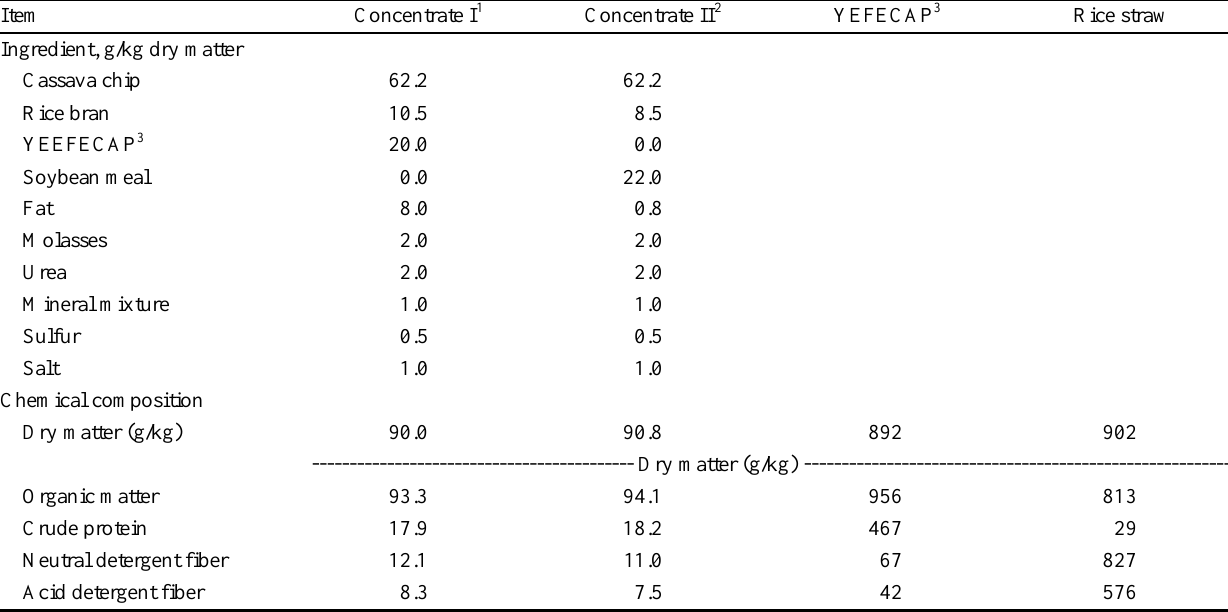
Table 1. Feed ingredients composition of dietary treatments used in the